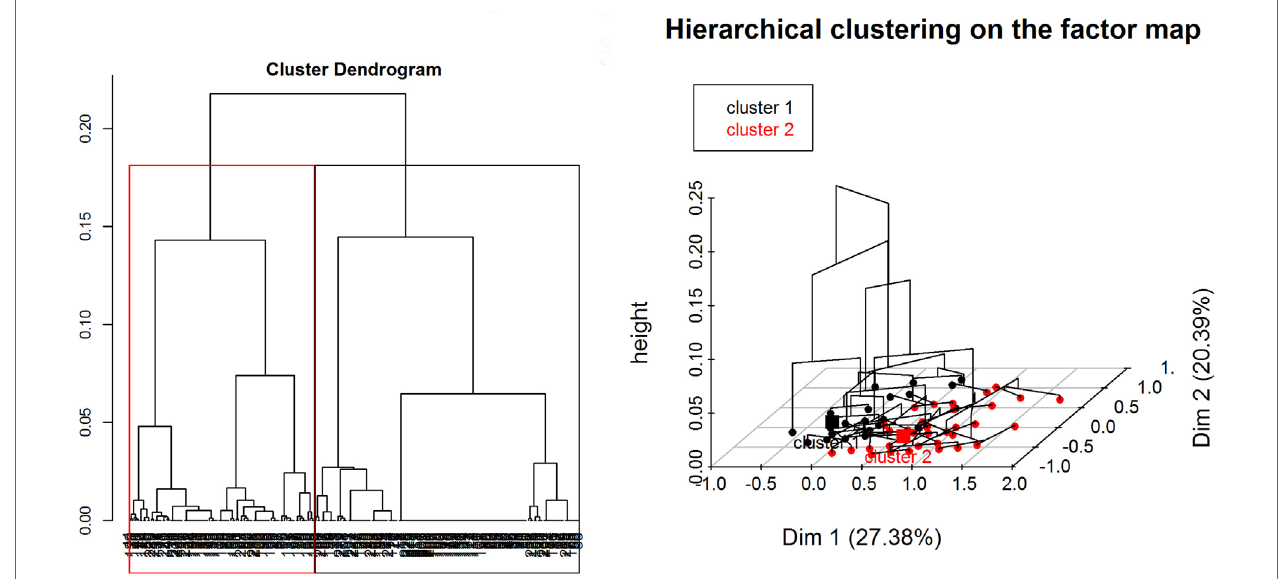
FigUre 7 | Divisive hierarchical clustering analysis of categorical variables from data collected during individual interviews carried out in pig owning household in nwoya District, Uganda, 2015 . Cluster one (black) and cluster two (red) (please refer to the online colored version) divide the data in HH without and with ASF occurrence,